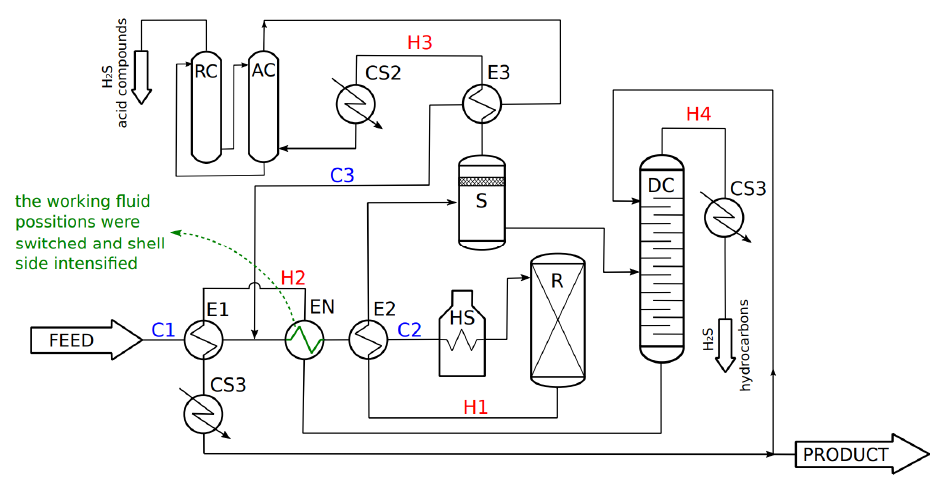
Figure 9. Process diagram of the energy retrofit obtained from the DD stage.